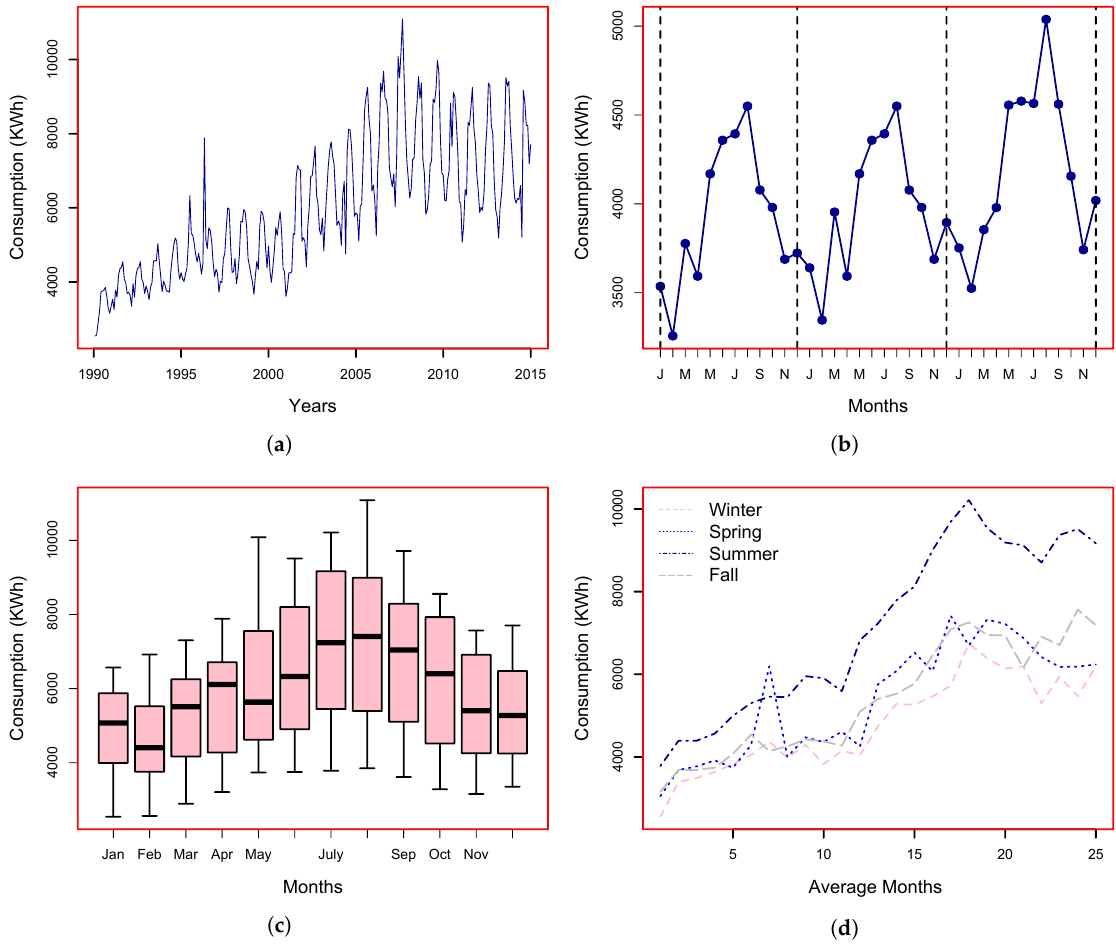
Figure 1. Pakistan electricity consumption (kWh): ( a ) Electricity consumption time series for the period January 1990 to December 2016; ( b ) yearly periodicity for the period January 2000 to December 2003; ( c ) box plot for monthly observation for the period January 1990 to December 2015; and ( d ) seasonal plot for the period January 1990 to December